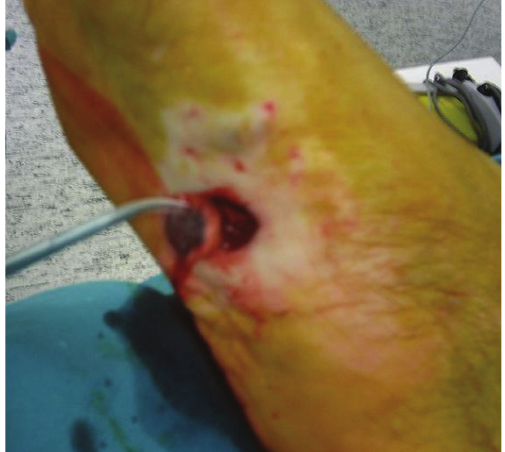
Figure 2: Perform of a wide local excision of the skin and underlying subcutaneous tissues with a margin of